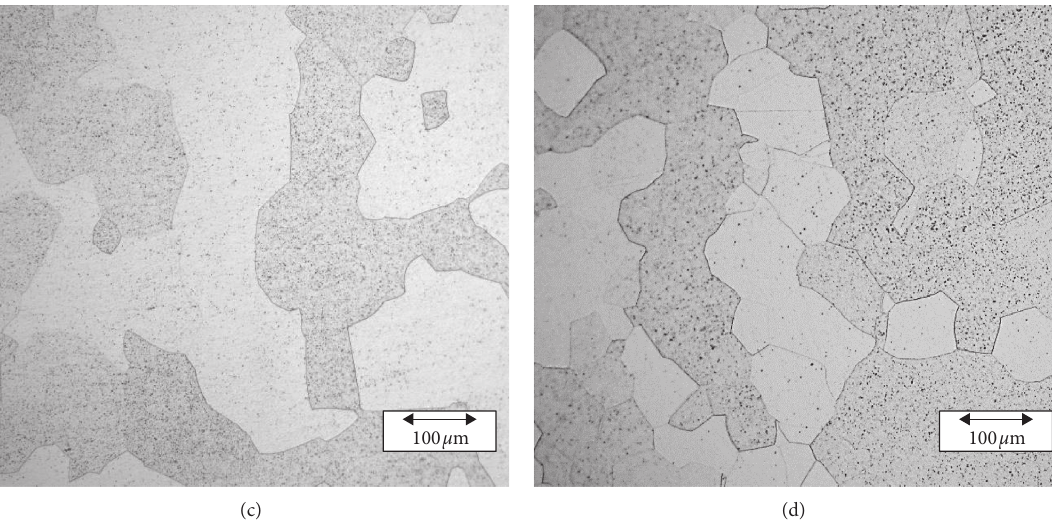
Figure 5: Comparison of the surface morphologies of untreated niobium (a), with samples submitted to HT-NPBII at treatment times of 1h (b), 4 h (c), and 8h (d), evidencing the enlargement of the grain sizes.